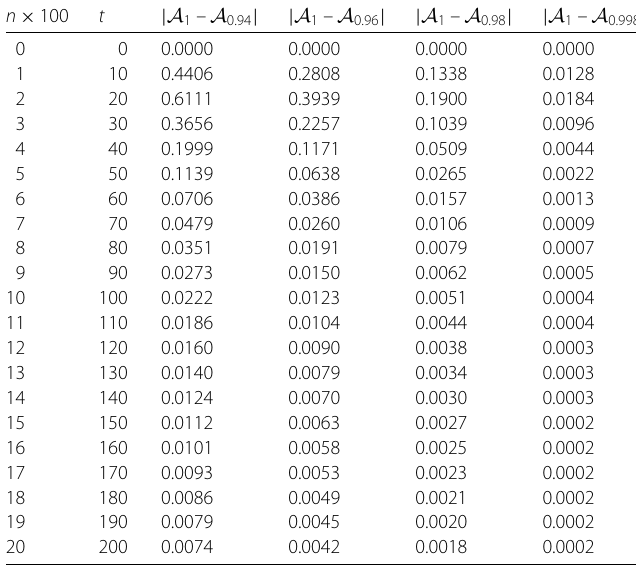
Table 4 The values of | A 1 – A φ | for φ = { 0.94,0.96,0.98,0.998